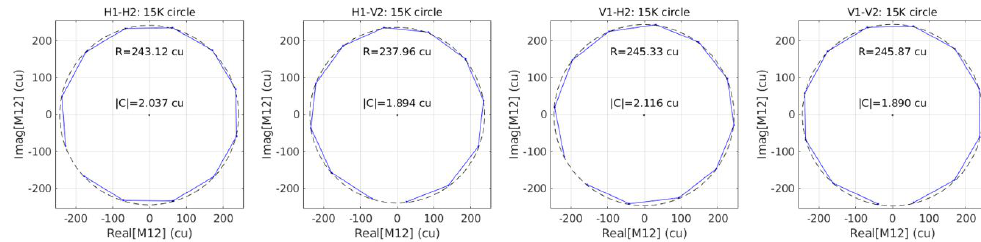
Figure 13. Sensitivity